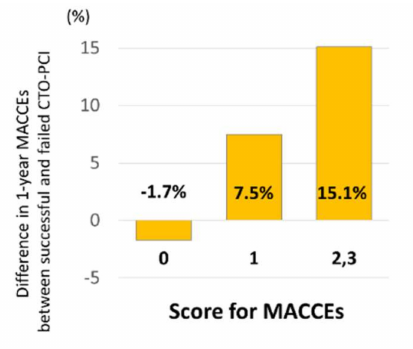
Figure 8. Di ff erence in one-year MACCEs between patients with successful CTO-PCI and those undergoing failed procedure, stratified by the score for MACCEs. Abbreviations: CTO, chronic total occlusion; MACCEs, major adverse cardiac and cerebrovascular events; PCI, percutaneous coronary